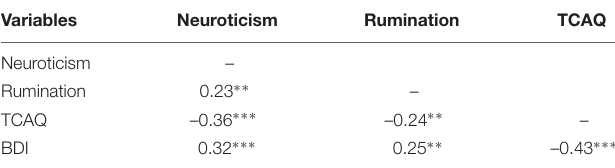
TABLE 4 | Correlations matrix in Study